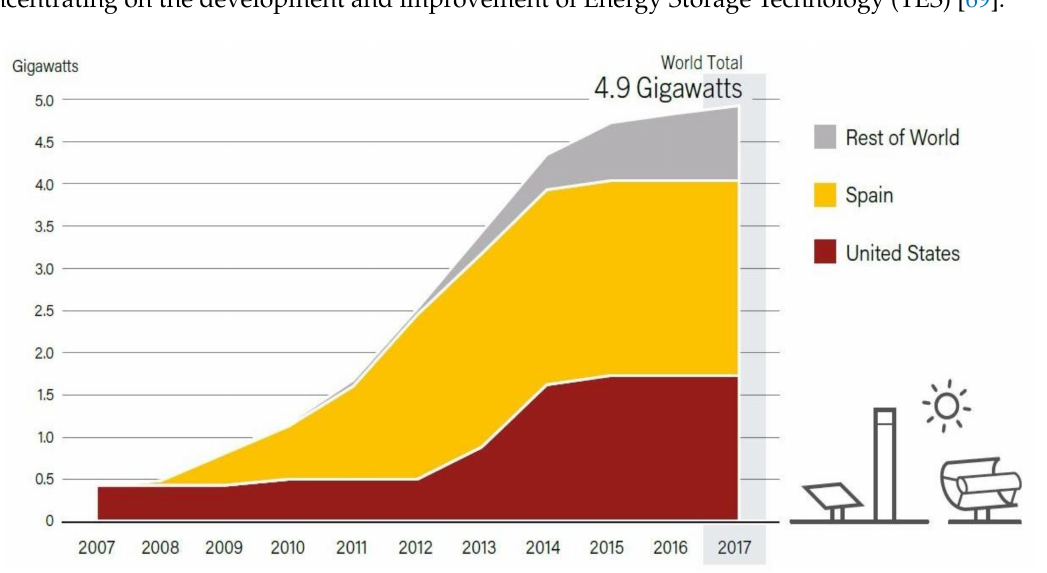
Figure 7. Concentrating solar thermal power global capacity by country and region over the period 2007–2017 [68].